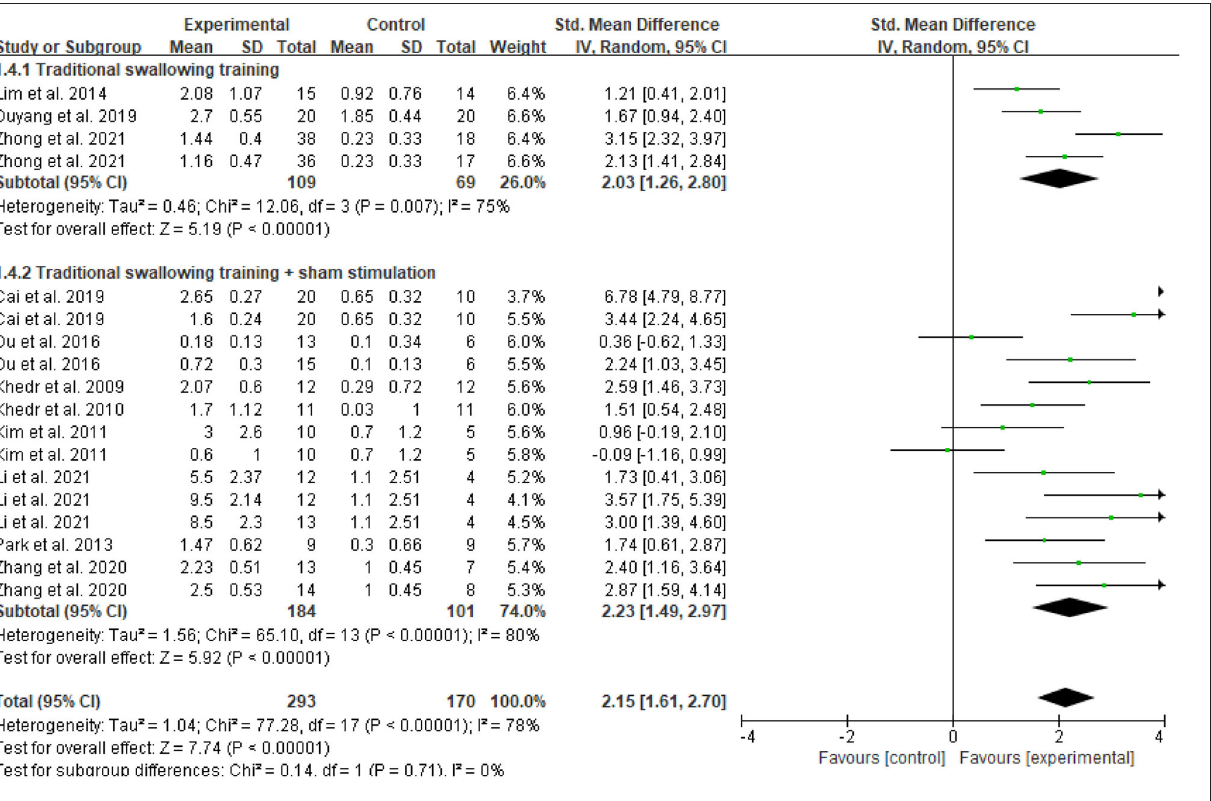
FIGURE 4 | Forest plot of the overall effect analysis of